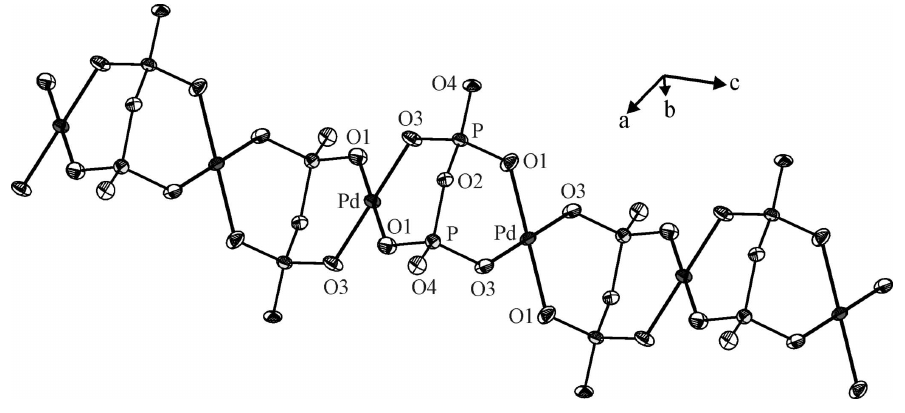
PdP O along [010] with tetrahedral [PO 2 2 7